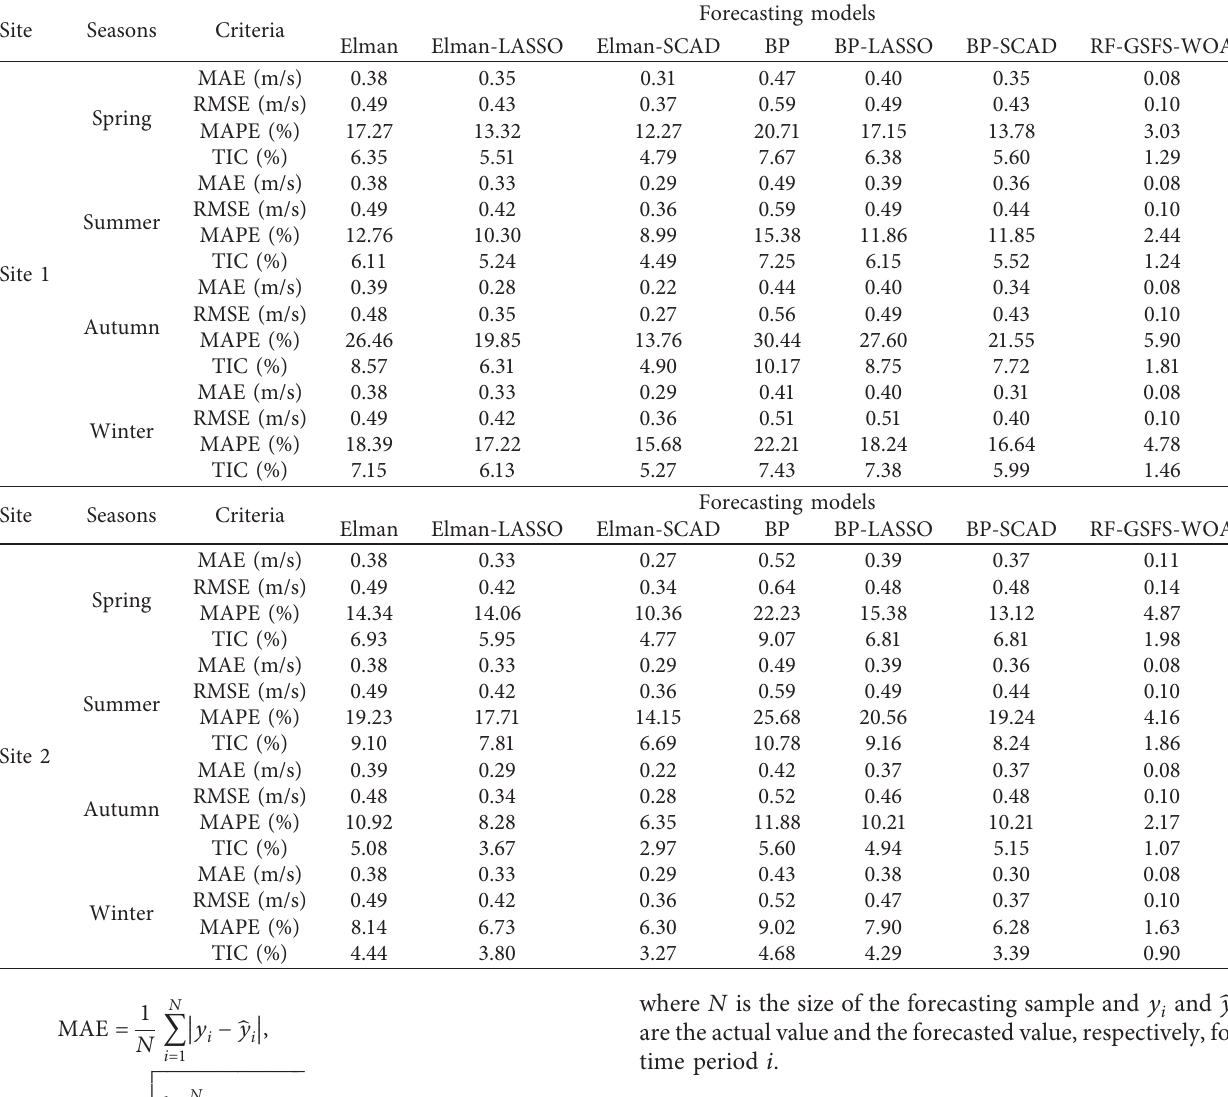
Table 3: Forecasting performances of the proposed model and other models in four seasons at Site 1 and Site